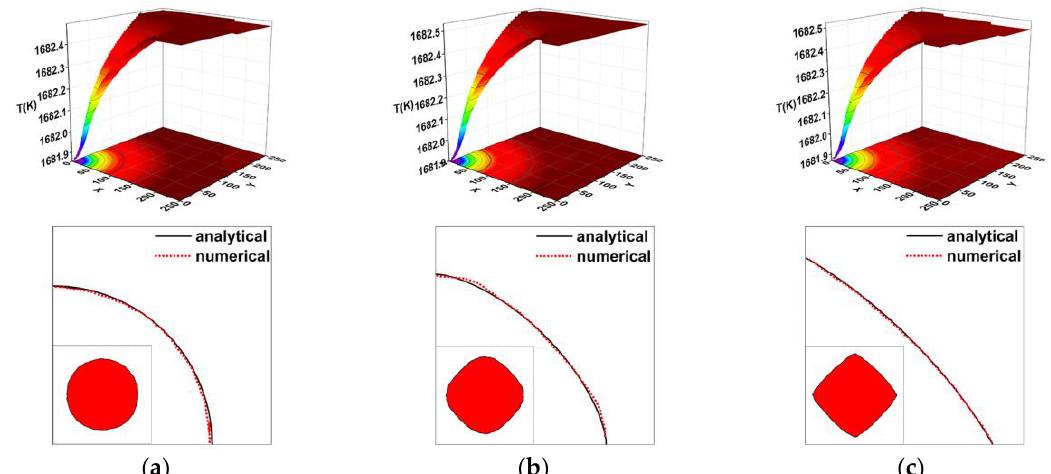
 and the comparison